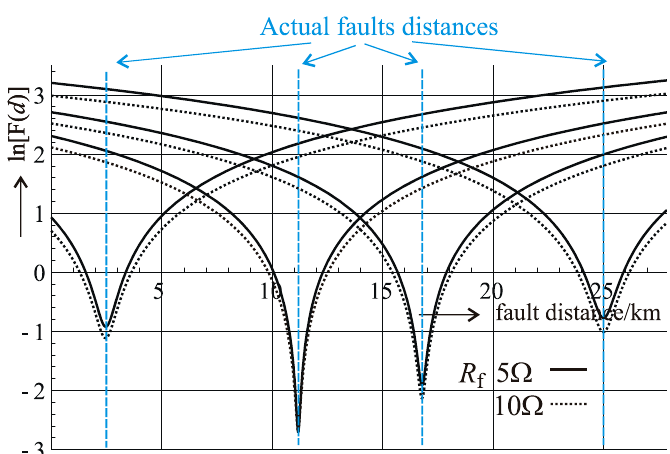
Figure 8. Results of the proposed algorithm for various fault distances.